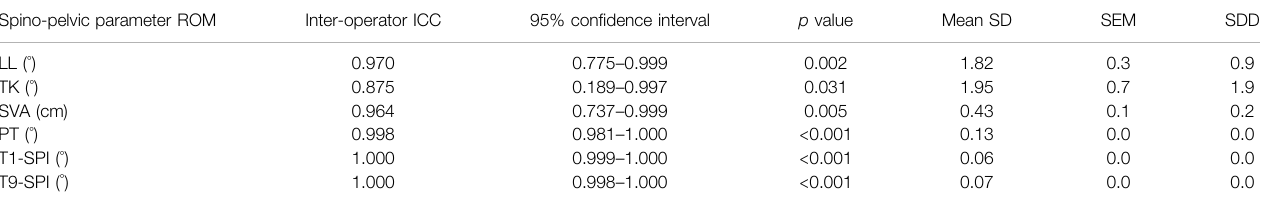
TABLE 2 | Results of the inter-operator reliability analysis. ROM, range of motion; ICC, intraclass correlation coef fi cient, SD, standard deviation of absolute error relative to mean value; SEM, standard error of measurement; SDD, smallest detectable difference. Signi fi cance level: p < 0.05 (bold). Spino-pelvic parameter ROM